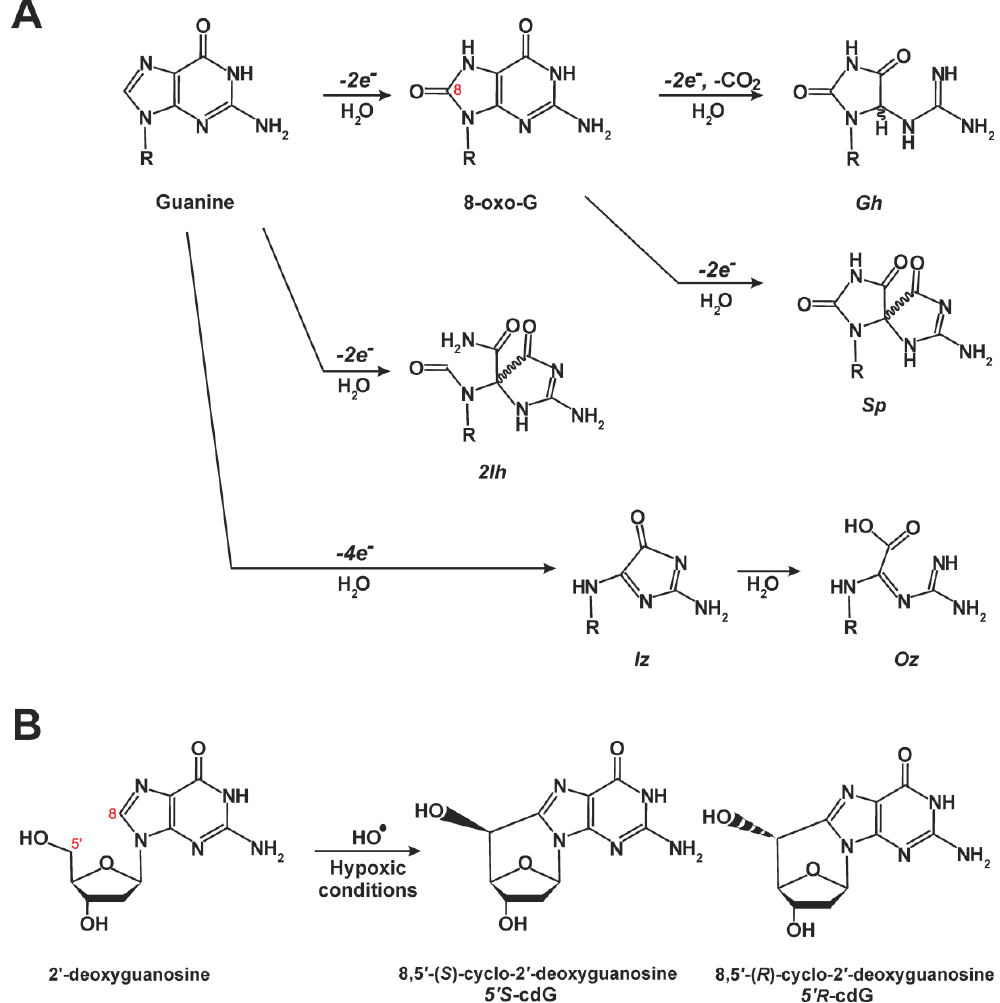
Figure 5. Chemical structures of common oxidative DNA lesions. ( A ) Guanine oxidation products. Products of two-electron guanine oxidation are 8-oxo-7,8-dehydroguanine (8-oxoG) and 5-carboxamido-5-formamido-2-iminohydantoin (2Ih). Four-electron guanine oxidation products are 5-guanidinohydantoin (Gh), spiroiminodihydantoin (Sp), 2,5-diamino- 4H-imidazol-4-one (Iz), and 2,2,4-triamino-5(2H)-oxazolone (Oz). ( B ) Formation of 8,5 (cid:48) -cyclo-2 (cid:48) -deoxyguanosine (cyclic guanosine, cdG) through hydroxyl radical (HO • ) oxidation under hypoxic